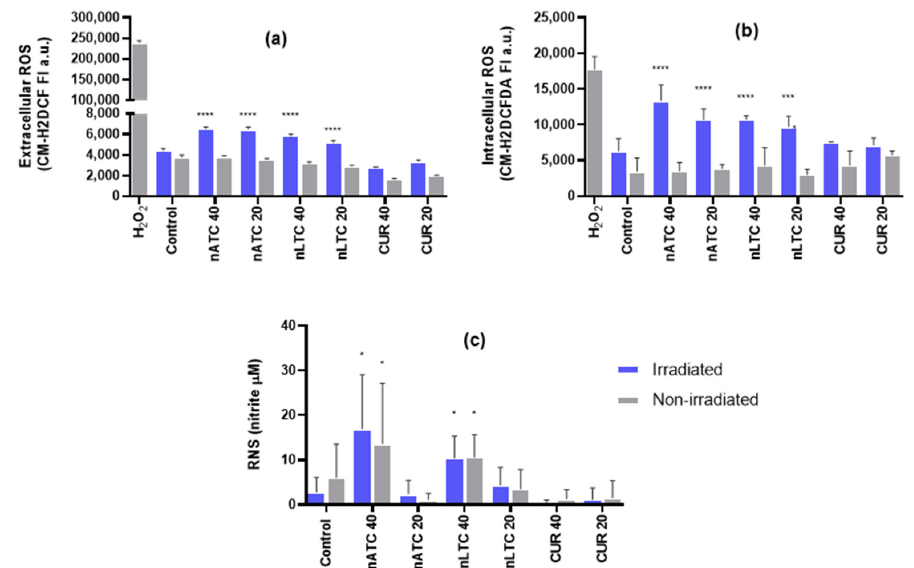
Figure 1. Absorbance and fluorescence spectra of 40 µ M ( a ) nATC, ( b ) nLTC, or ( c ) free CUR, before and after irradiation, with a fluence of 9 J/cm 2 .